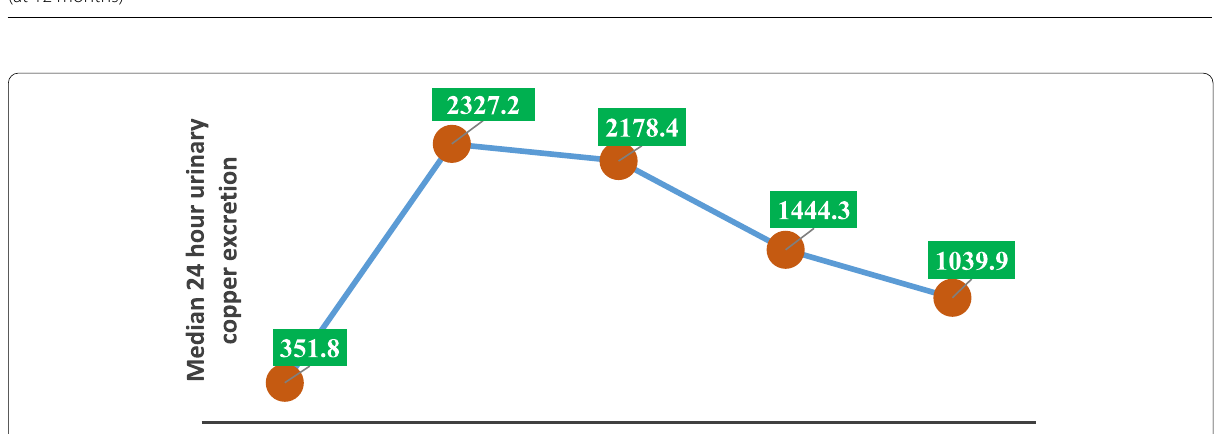
Fig. 11 Median 24 h urinary copper by line chart (survived, n